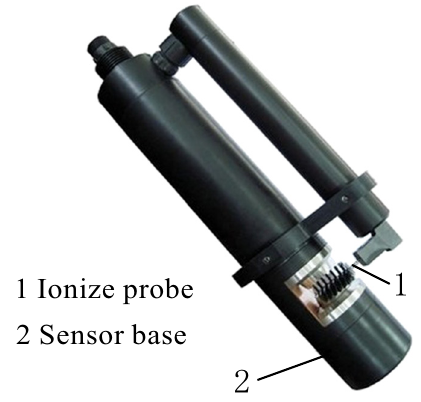
Figure 7: Infrared sensor diagrams. Figure 8: Schematic diagram of ultraviolet